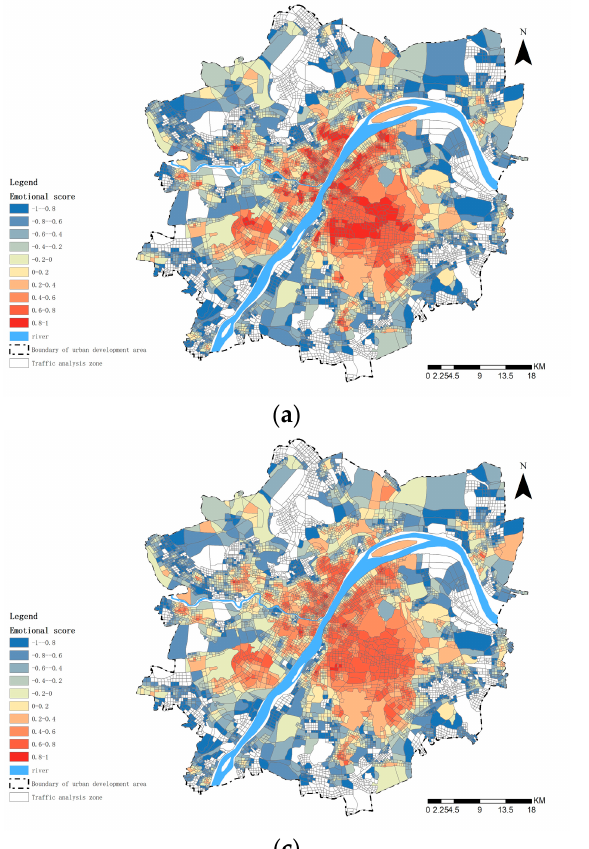
Figure 7. Spatial distribution of emotions. ( a ) Average score; ( b ) Top quartile score; ( c ) Lowest quartile score.